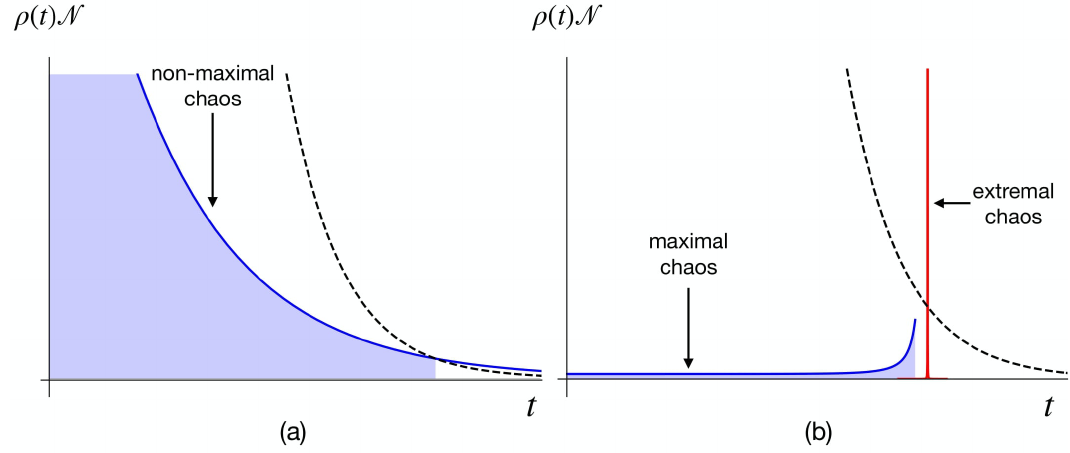
Figure 4 . Density functions (4.2) associated with various chaotic systems are shown here schemat- ically. The dashed black line represents the bound (4.3). Figure (a): the blue line is the density function for a period of Lyapunov growth with 0 < λ inconsistent with the bound (4.3) for large t , where correction terms must become significantly large so that the density function decays faster. Figure (b): the blue line represents a typical density function associated with a period of maximal chaos. Over the same duration of time the density function ρ ( t ) ≈ 0 , however, it starts to grow around some time scale t = t the delta-function density associated with the extremally chaotic